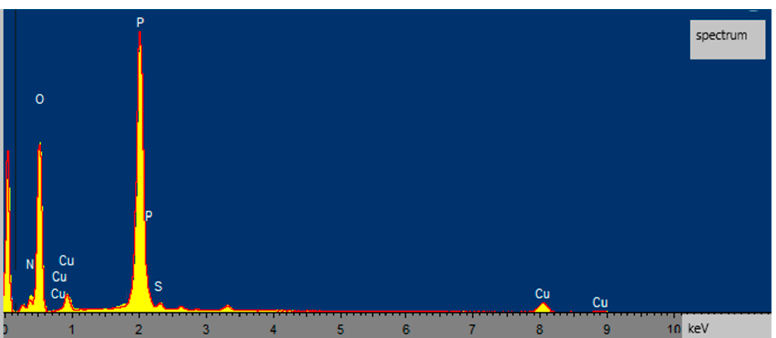
Figure 7. SEM-EDX analysis of residues collected after five cycles of phosphine oxidation.